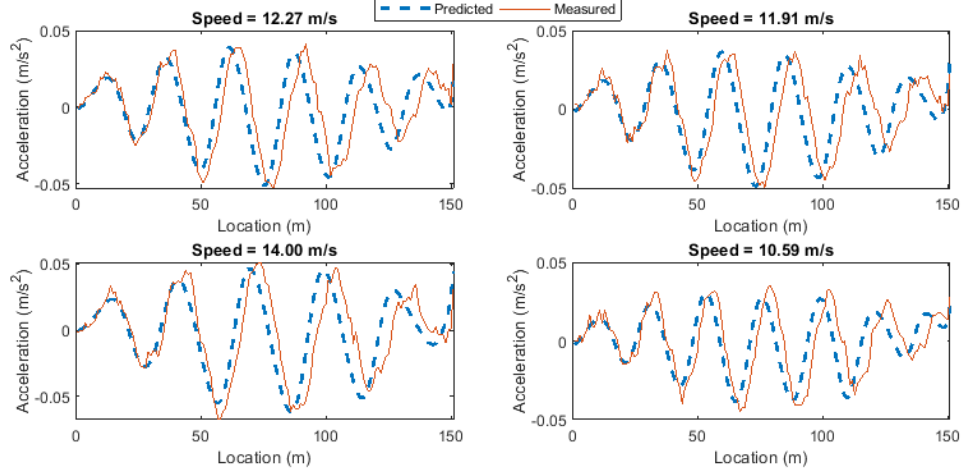
Figure 6. The comparison of the predicted and measured vehicle responses for the first four passes over the damaged bridge with crack ratio of 0.3.